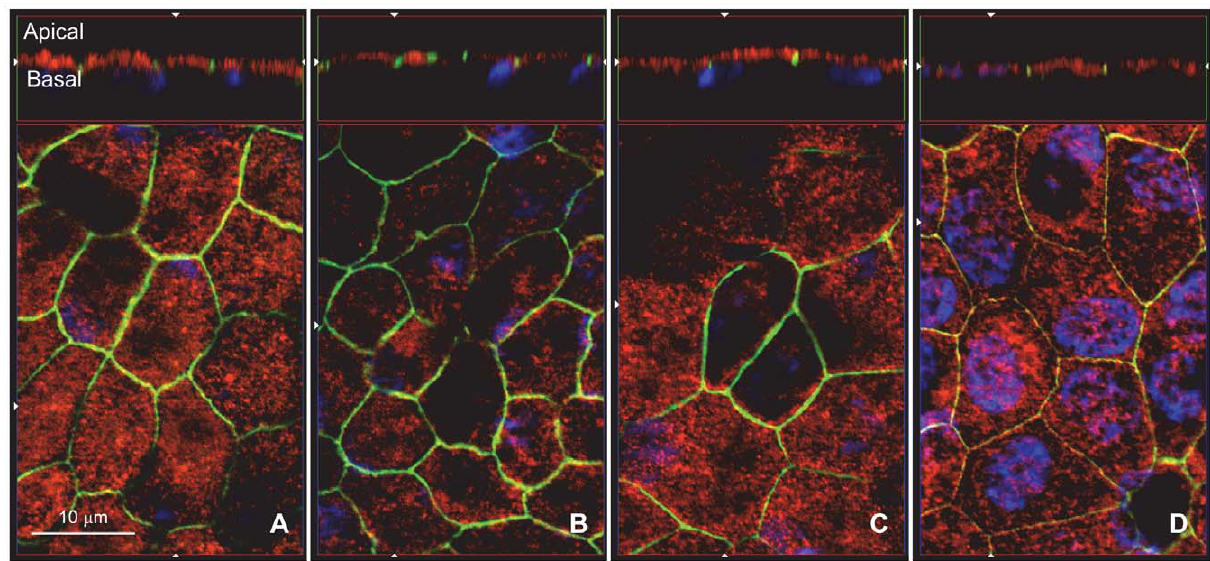
Figure 5. Immunofluorescence localization of CNTF, CT1, OsM receptors on hfRPE. Central part of each panel is an enface view of cell culture monolayer, shown as a single optical section obtained from a Z-stack. Nuclei were stained with DAPI (blue) and ZO-1 tight junction marker stained green. Images of the cross section through the Z-plane are shown at the top of each panel. CNTFR a (A, red), LIFR b (B, red), gp130 (C, red) and OsMR b (D, red) were detected mainly on the apical membrane of confluent monolayer of hfRPE.